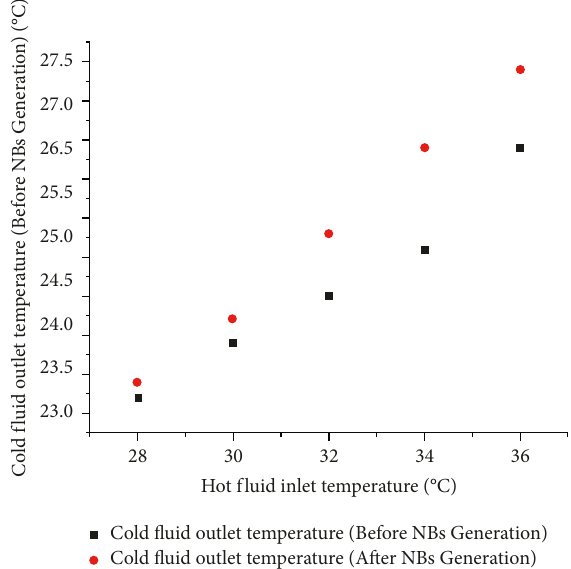
Figure 3: Influence of nanobubbles on cold fluid (air)